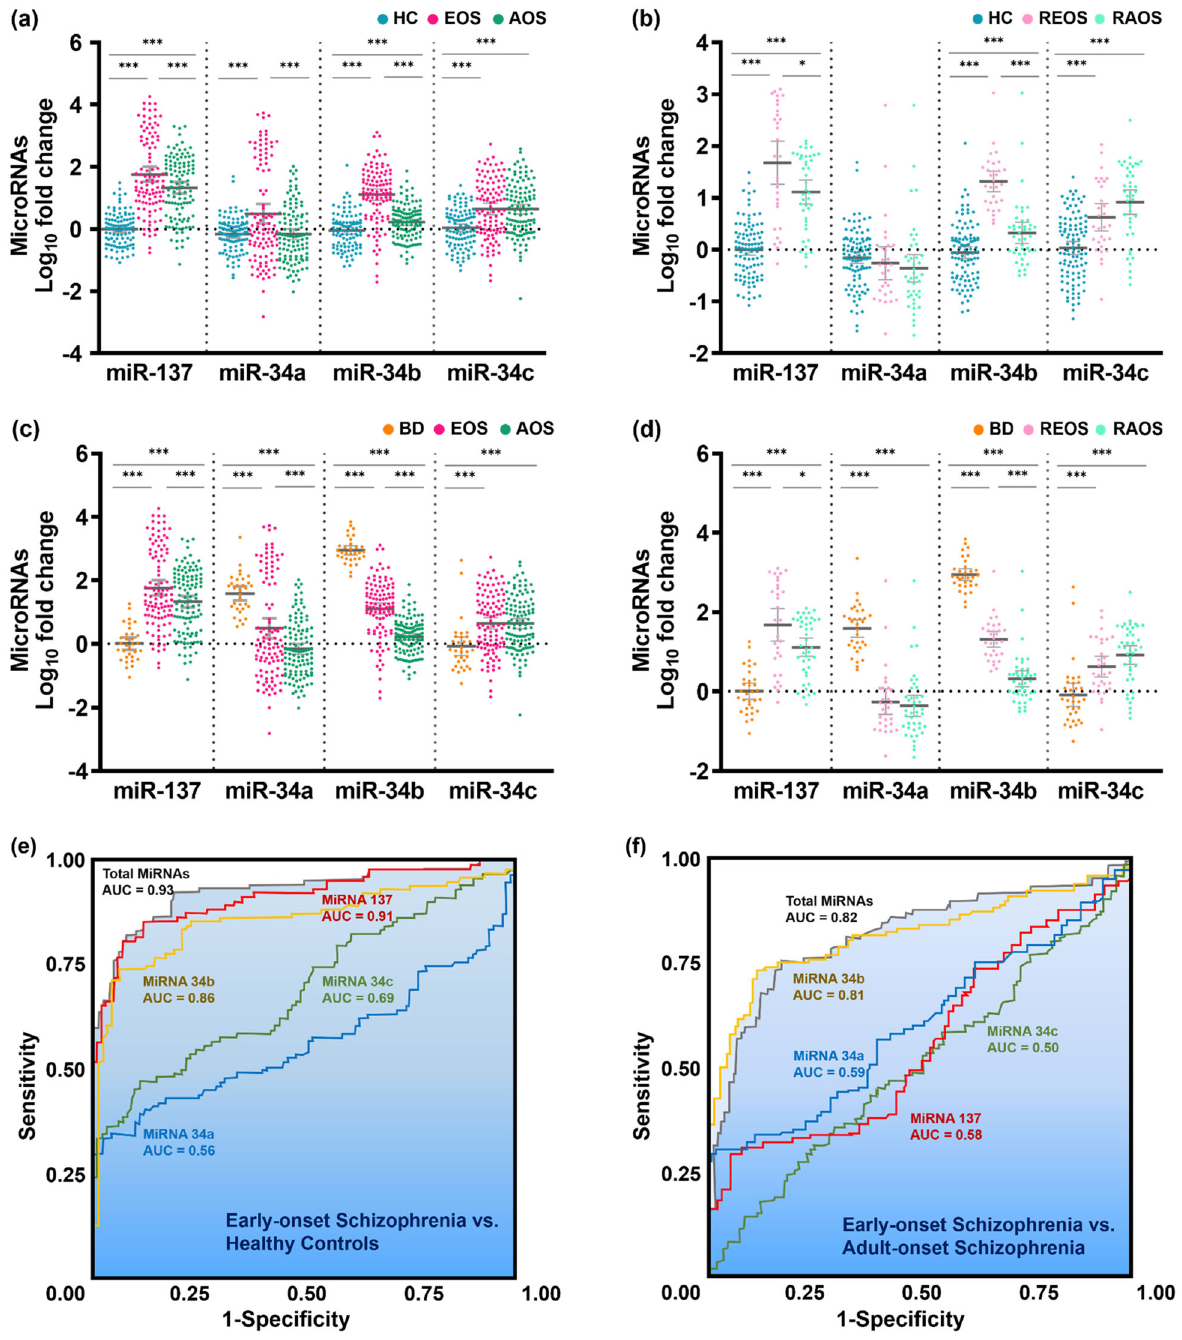
Fig. 1 Comparison of microRNA expression levels between patients with early-onset and adult-onset schizophrenia, unaffected relatives of patients with schizophrenia, patients with bipolar disorder, and healthy controls. a The expression levels of the four-miRNA in the peripheral blood of EOS, AOS and HC. b The expression levels of the four-miRNA in the peripheral blood of REOS, RAOS and HC. c The expression levels of the four-miRNA in the peripheral blood of EOS, AOS and BD. d The expression levels of the four-miRNA in the peripheral blood of REOS, RAOS and BD. e Receiver operating characteristic (ROC) curve analysis of miR-137 expression levels between patients with early-onset schizophrenia and healthy controls. f ROC curve analysis of miR-34b expression levels between early-onset and adult-onset schizophrenia. AOS adult-onset schizophrenia, EOS early-onset schizophrenia, RAOS unaffected fi rst-degree relatives of AOS patients, REOS unaffected fi rst-degree relatives of EOS patients, BD bipolar disorder, HC healthy controls. * p < 0.05; ** p < 0.01; *** p < 0.001. Error bars represent standard errors of the improved the separation between patients with SZ and HC The correct classi fi cation accuracy and 10-fold cross-validation (Fig. 2a, b). Mir-137 and miR-34b acted as appropriate classi fi ers accuracy from the discriminant analysis between all patients with for the EOS patients vs. HC (Fig. 2c, d). Moreover, miR-34b was the SZ, EOS patients, AOS patients, and HC are shown in Supplemen- best PLS factor to distinguish between EOS and AOS patients tary Table 7. The PLS-DA results showed that miR-137 expression